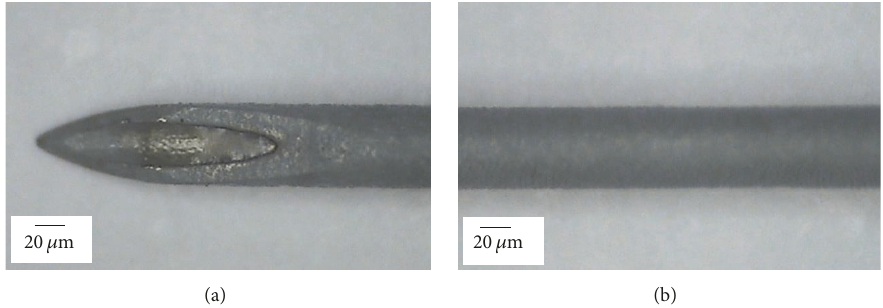
Figure 2: Optical micrographs of the substrate surface (a) at the end and (b) along the short hollow